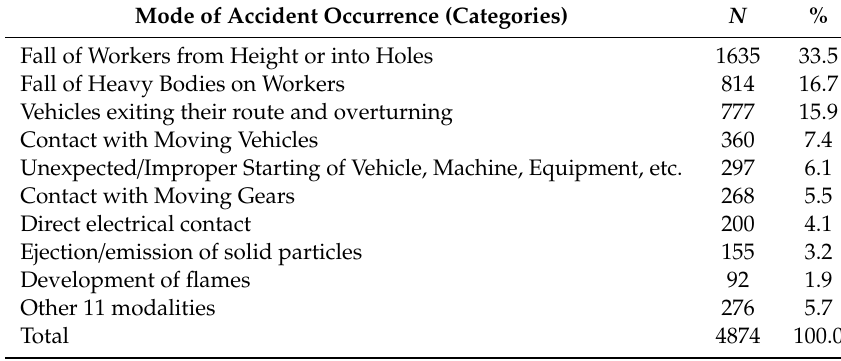
Table 2. Distribution of fatal accidents by mode of occurrence. Number (N); column percentage (%).